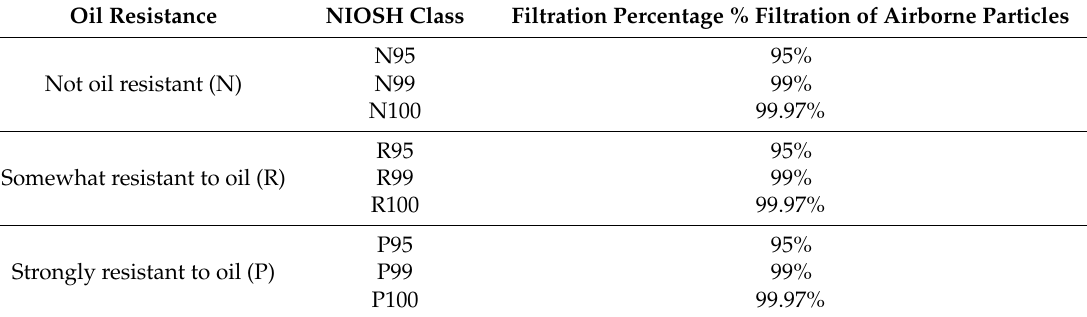
Table 3. Characteristics of masks according to US